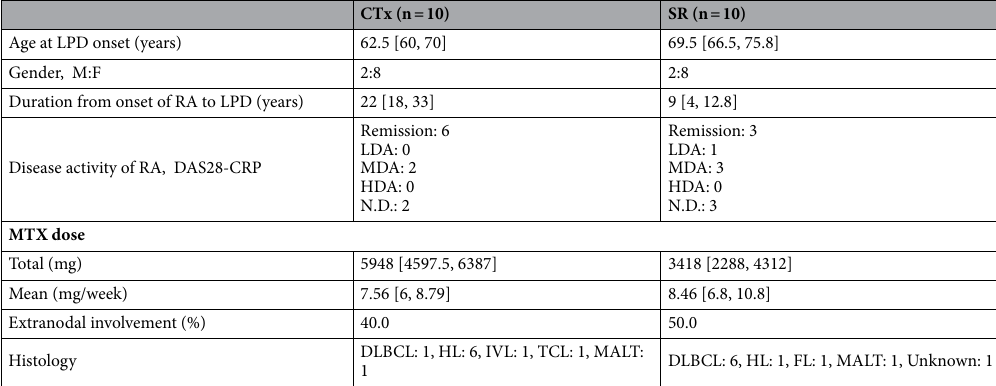
Table 1. Clinical profiles of the MTX-LPD patients. Median [IQR]. LDA low disease activity, MDA moderate disease activity, HDA high disease activity, N.D. no data, DLBCL diffuse large B-cell lymphoma, HL Hodgkin